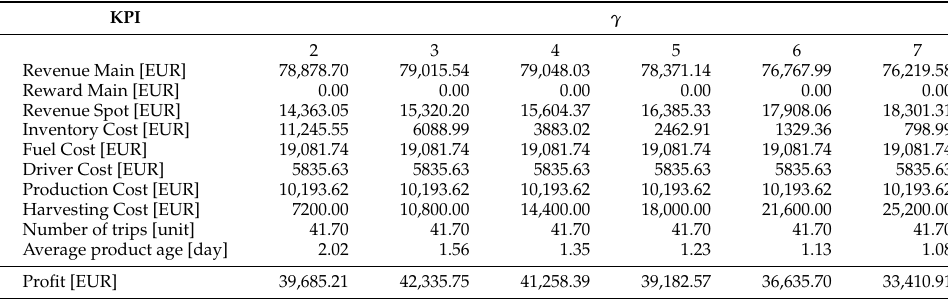
Table 12. Average KPIs for the case of δ = 0.75 (company C 2